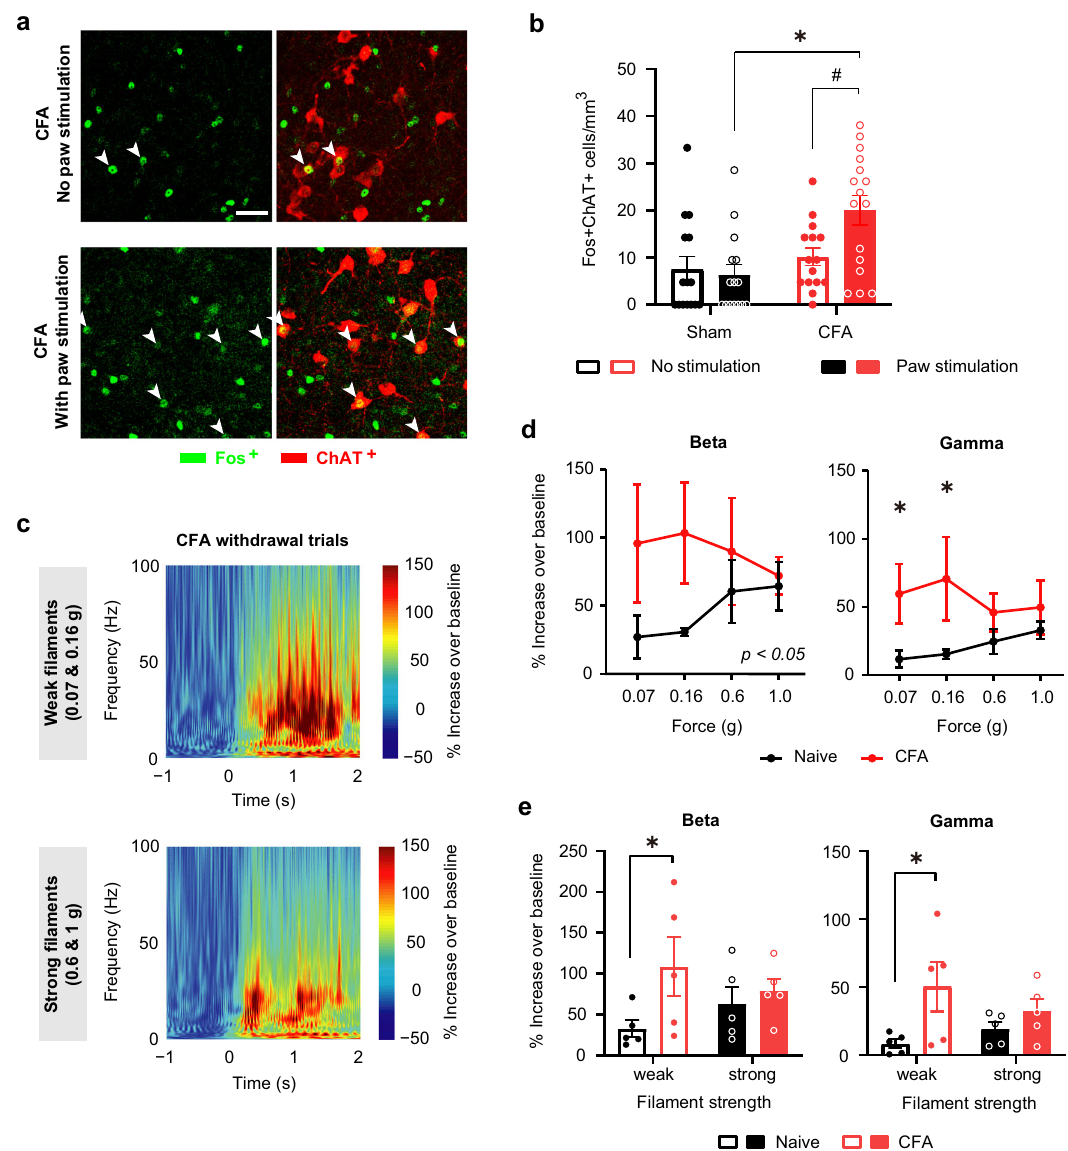
Fig. 2 | Enhanced responsivity in cholinergic neurons and increased power of beta and gamma oscillatory activityin the NBM atpeakofin fl ammatory pain- likebehavior.a , b ComparisonoftheactivityofcholinergicneuronsoftheNBMin the presenceor absence ofapplication of mechanical stimulation with 0.16g force to the contralateral plantar hindpaw under baseline conditions or 1 day after CFA injection. Shown are typical examples ( a ) and quanti fi cation ( b ); n =4 mice/group; P <0.05 (*0.0005, # 0.0134), two-way ANOVA with Sidak ’ s multiple comparisons test. c Time – frequencyrepresentationofspectralpowerintheNBMinmiceatday1 after CFA injection ( n =5 mice/treatment). d , e Comparison of the power of